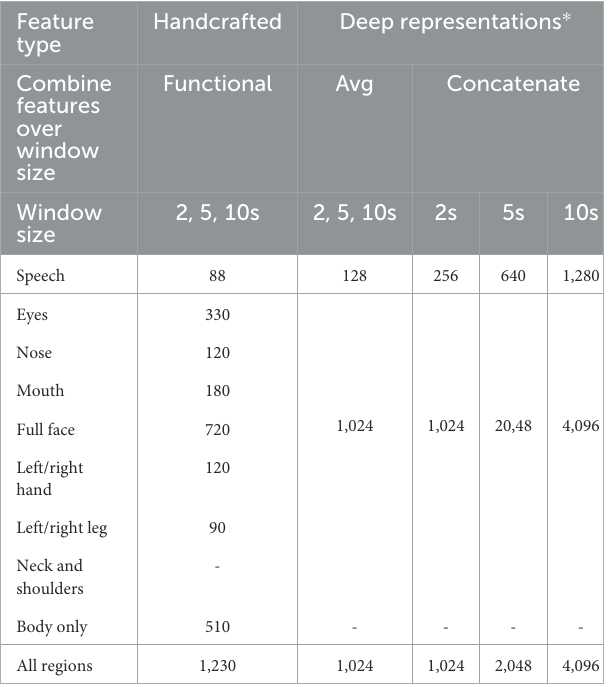
TABLE 2 Length of feature vectors for both handcrafted and deep representation in different timespans and feature combination over the